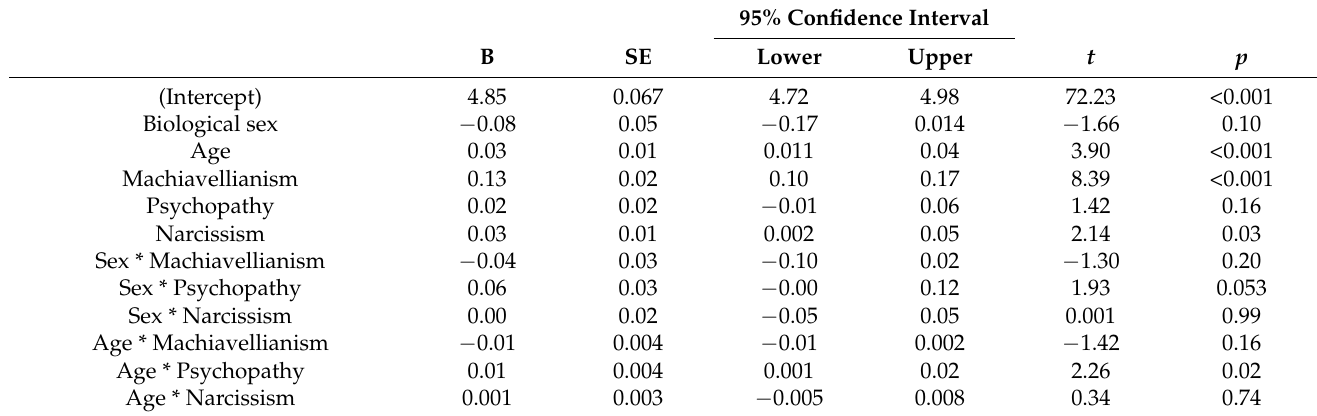
Table 5. Sharing own sexts: parameter estimates of fixed effects.